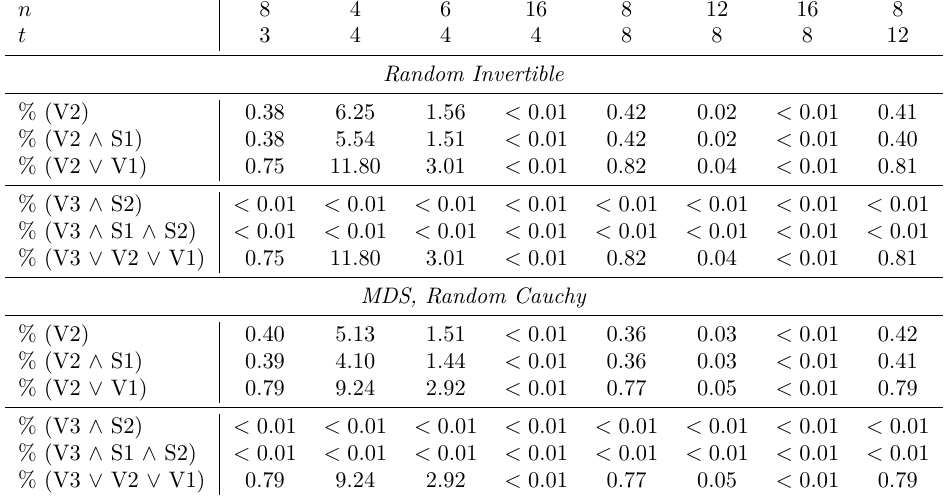
Table 4: Percentage of vulnerable matrices using Algorithm 1, Algorithm 2, Algorithm 3 over binary fields F t . We denote by “S x ” and “V x ” the security and vulnerability w.r.t. 2 n Algorithm x , respectively (e.g., S1 denotes security w.r.t. Algorithm 1, while V2